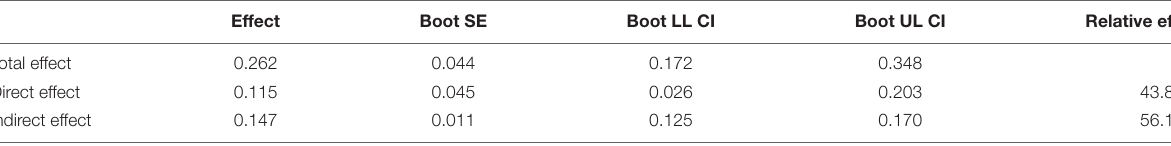
TABLE 3 | Total effect, direct effect, and mediating effect breakdown table.